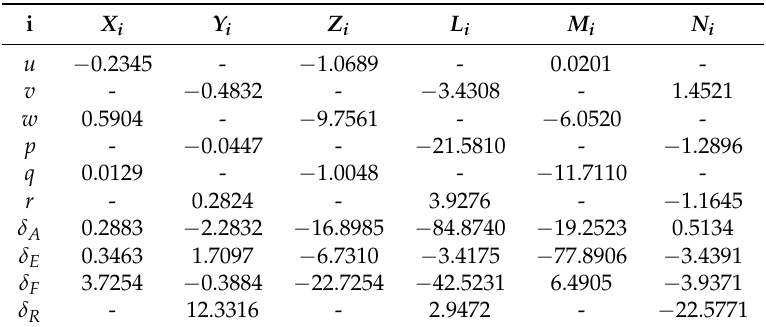
Table 5. Parameters estimated from multisine